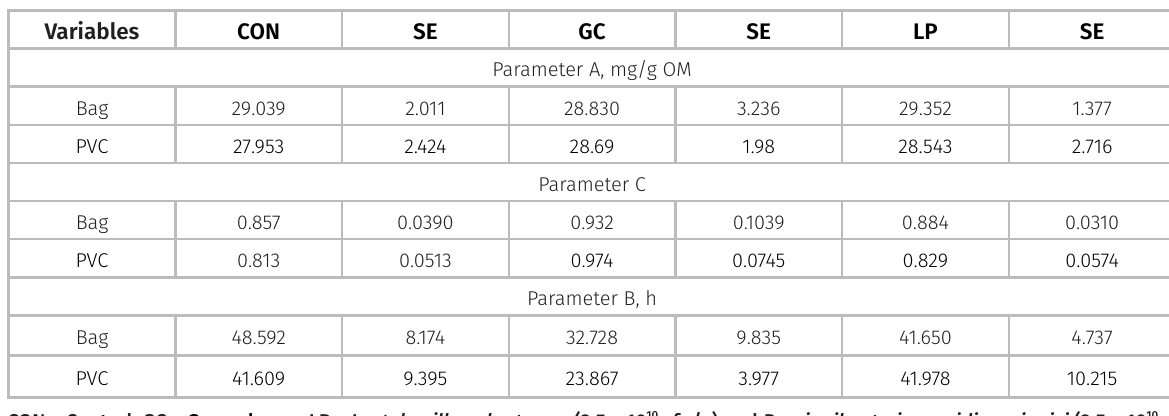
Table IV. Effects of additives on losses, and dry matter recovery of pearl millet silage. Variables CON Gas losses, % DM